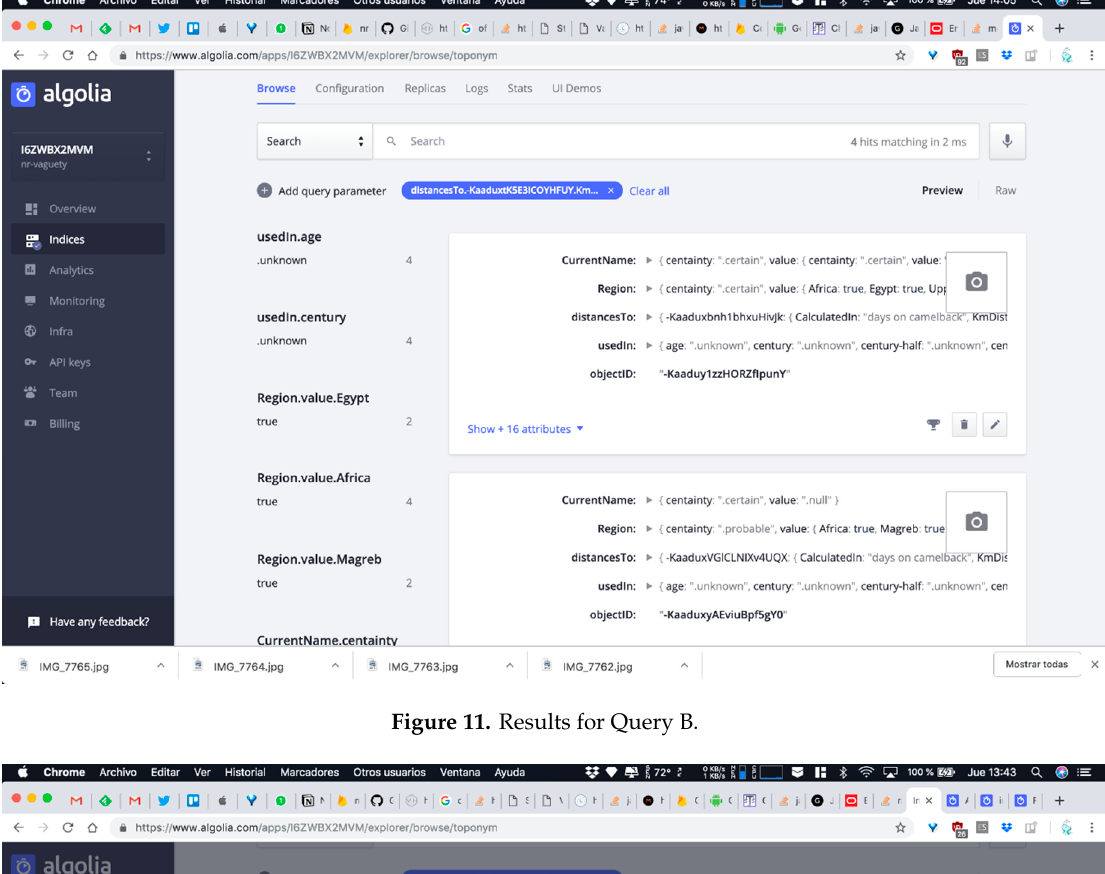
Figure 11. Results for Query B.